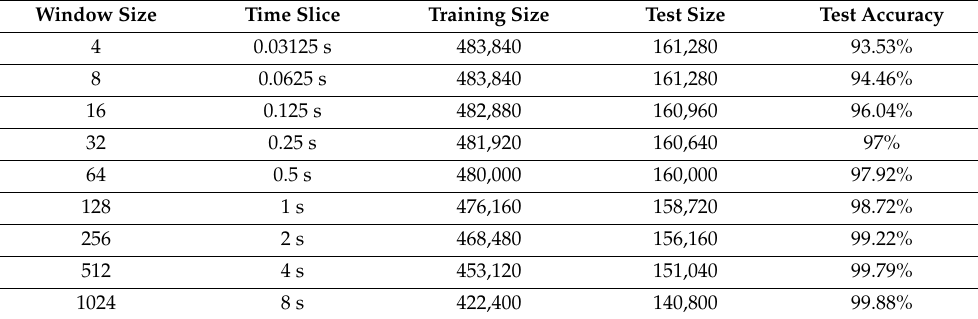
Table 11. Varying window size with respective time slice using FFT on M2 + FFT + FE-3 for valence. Window Size Time Slice